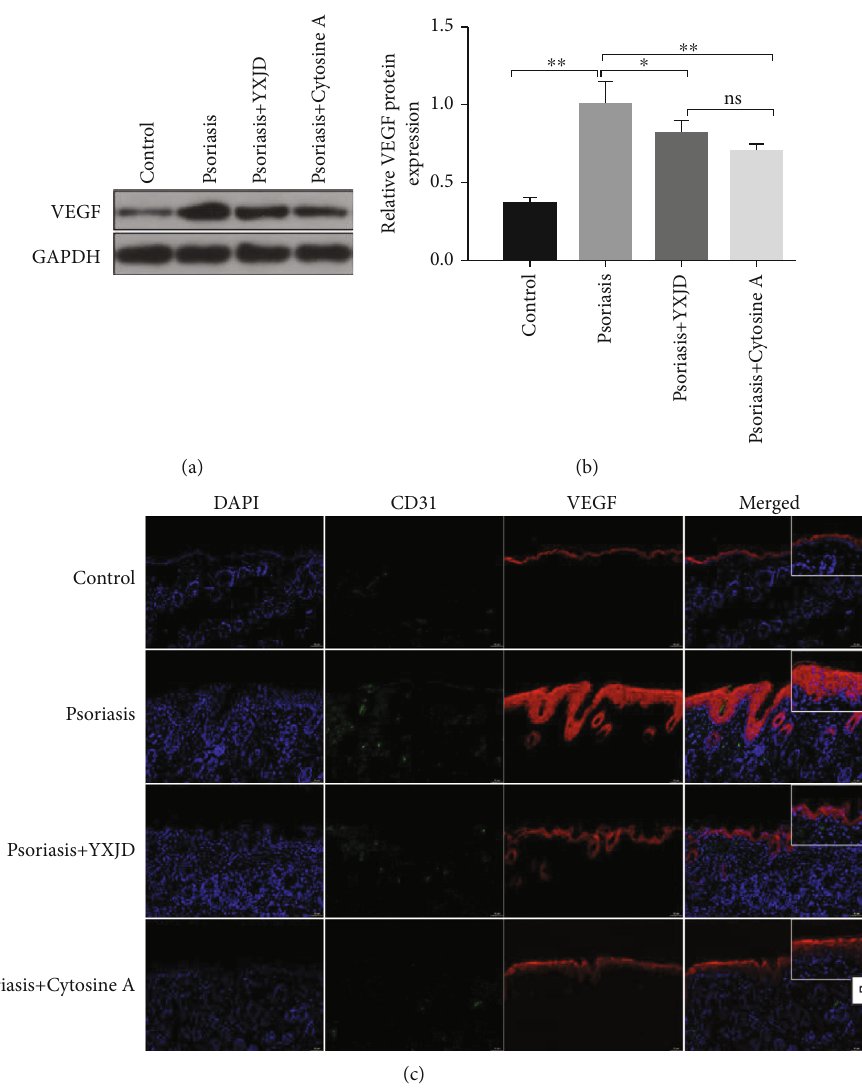
Figure 5: Protein levels and localization of VEGF, as detected by Western blot and immunochemical staining and immuno fl uorescence analysis VEGF expression, were evaluated by Western blotting (a). The expression of VEGF increased in the model groups compared with the control groups, and YXJD inhibited the expression of VEGF in the lesions of IMQ-induced PA mice (b). VEGF protein expression in the mice was measured by immunochemical staining and immuno fl uorescence analysis (d). Double immuno fl uorescence staining for CD31 (green), VEGF, and Survivin (red) in a representative skin sample from the 4 groups is shown. Nuclei were counterstained with DAPI